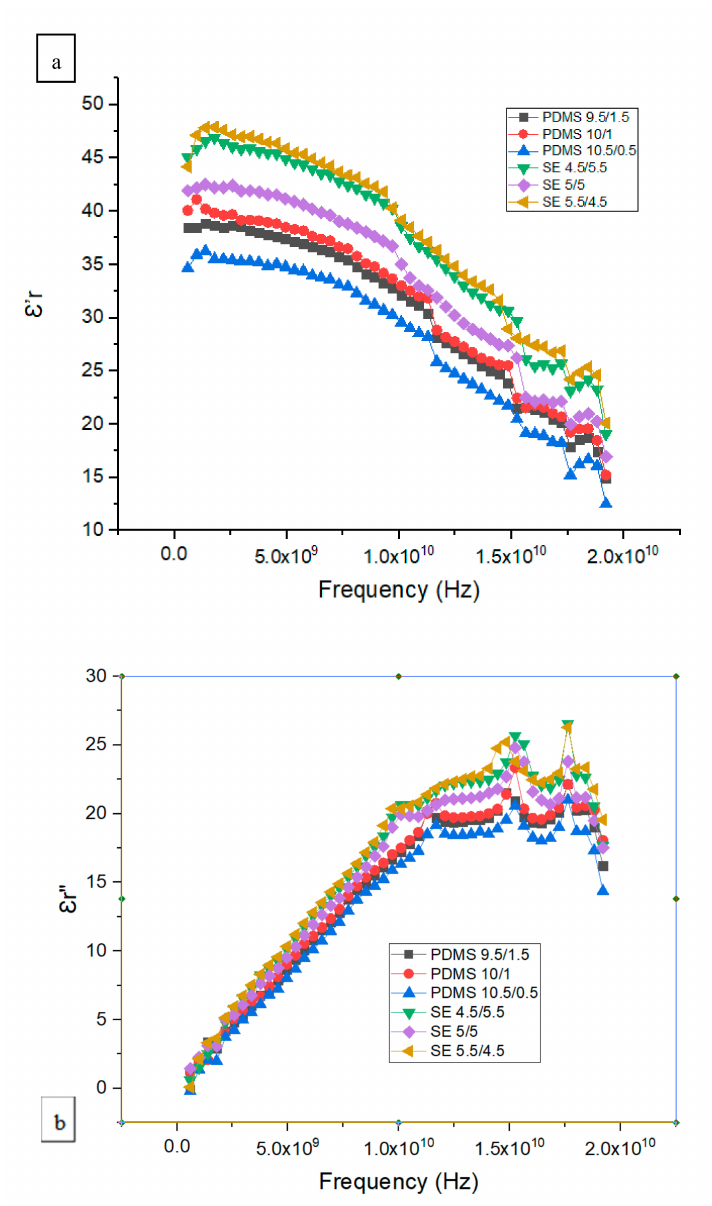
Figure 8. ( a ) The real part of the complex dielectric constant ε (cid:48) r and ( b ) the dielectric loss ε r (cid:48)(cid:48) for various mixtures of PDMS and